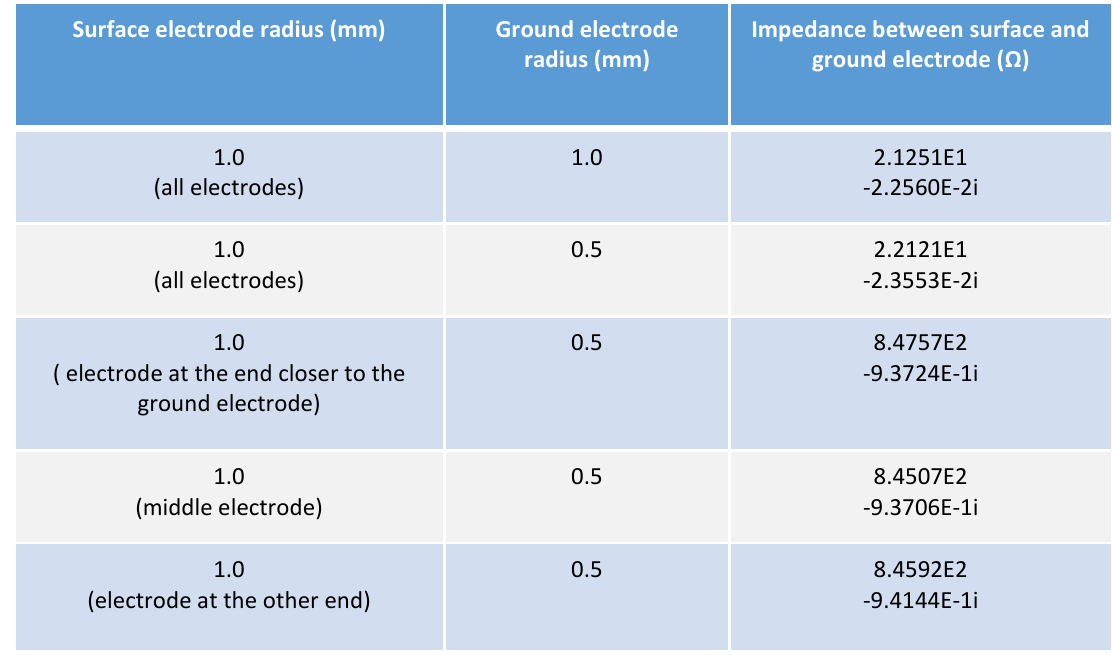
Table.13: Impedance measurements at 1MHz with both all and one of the 44 surface electrodes as terminals (11 electrodes in 4 rows)